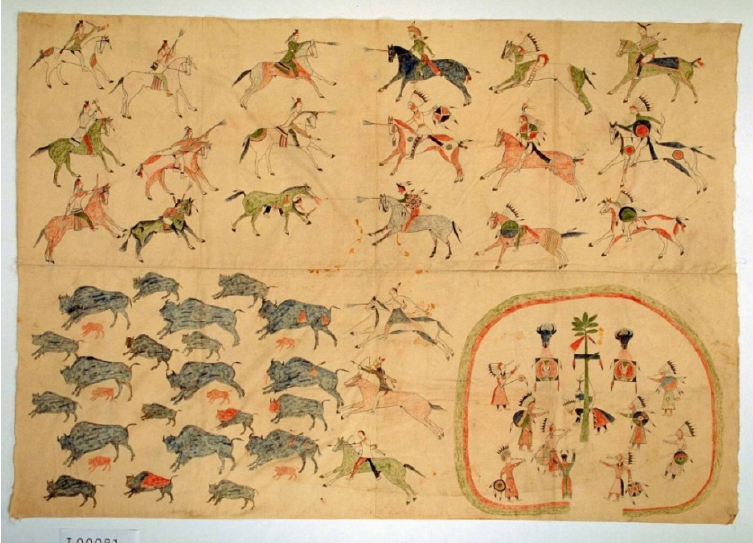
Figure 5. Painting on Muslin. Attributed to Siyosapa (Hunkpapa/Yanktonai) Collected at Fort Peck, Montana in 1880/1881. Cotton muslin, paint, 259 cm × 178 cm. Used by permission of National Museum of Natural History (EL81-0).